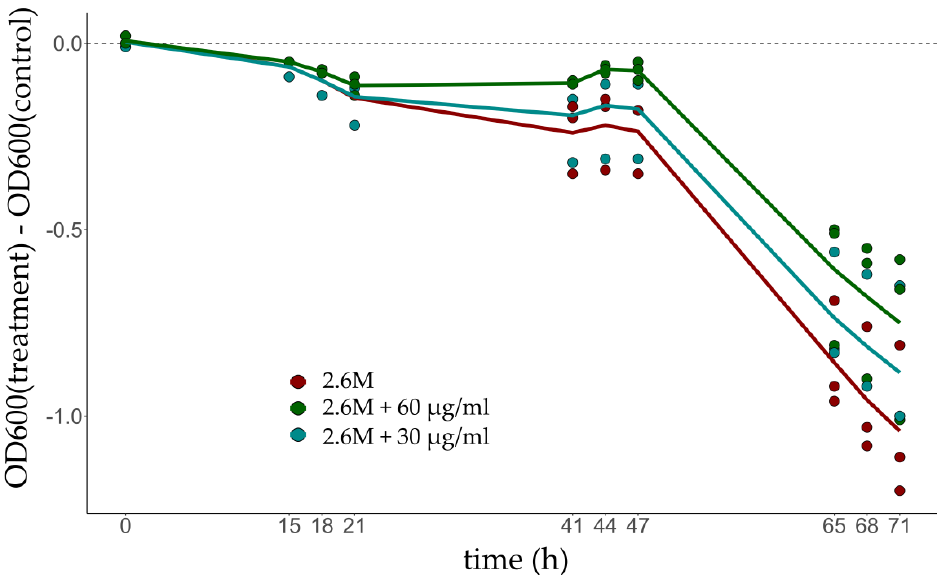
g (blue) and 60 μ